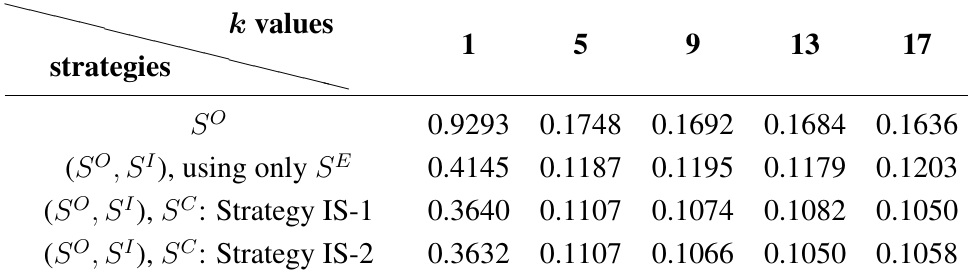
Table 3. The k-NN error rates (%) of using the S O feature only and using two-dimensional features, i.e ., ( S I , S O ), respectively. S E is calculated by Strategy IS-2 and S O is calculated by Strategy